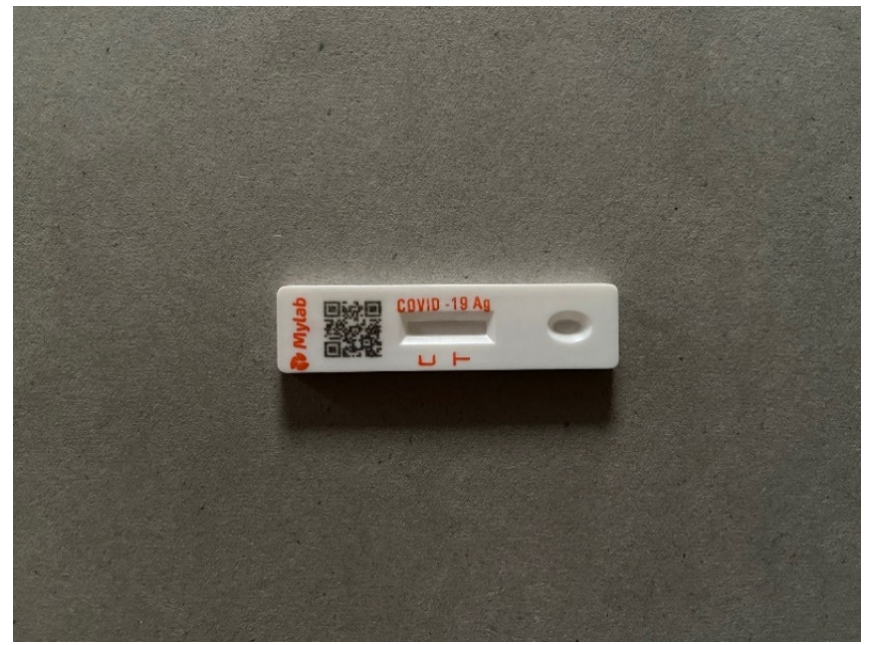
Figure 2. The CoviSelf test card. (From the far left: the QR code, the control point C, the test point T and the sample well for receiving the nasal mixture). Source: Ms Anusha Kesarkar-Gavankar, photograph of 18 November 2021.